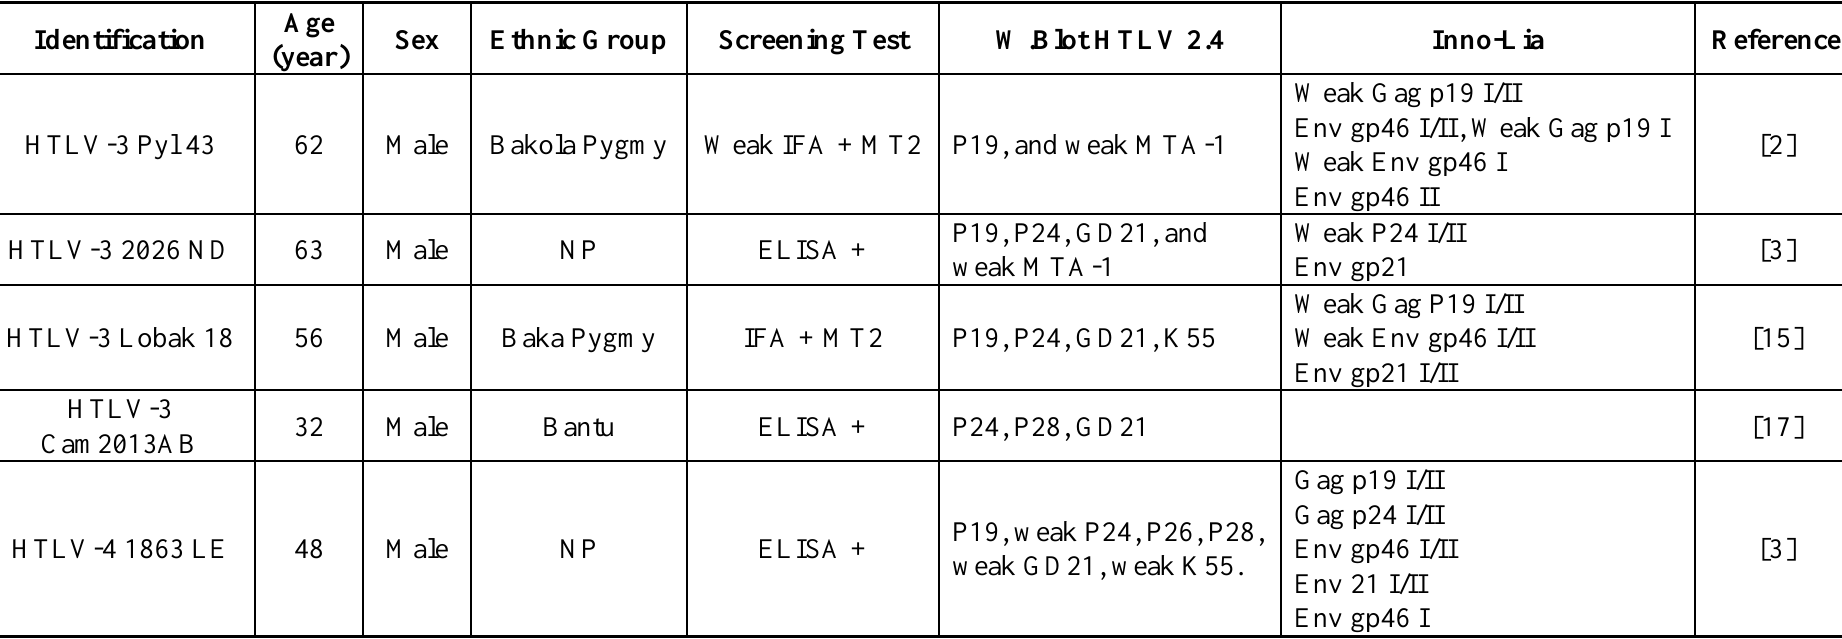
Table 1. Main epidemiological and HTLV serological characteristics of the 5 individuals infected either by HTLV-3 (n = 4) or HTLV-4 (n = 1). The five infected individuals lived in the forest area of South Cameroon and were hunters of non-human